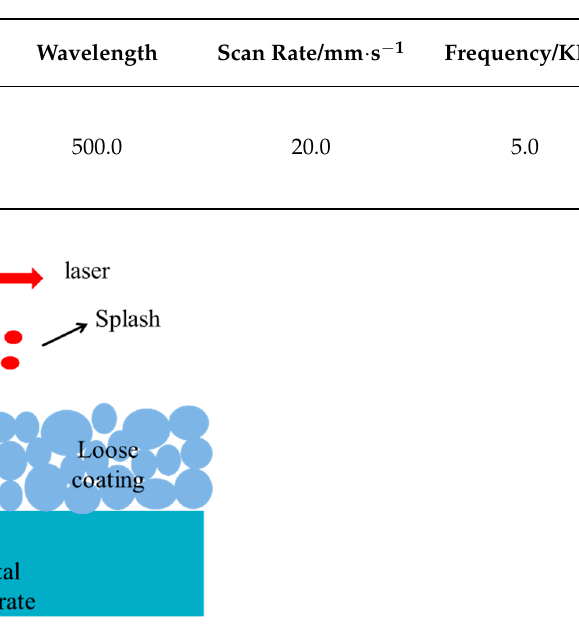
Table 2. Laser re-melting parameters for CS FAA coatings.